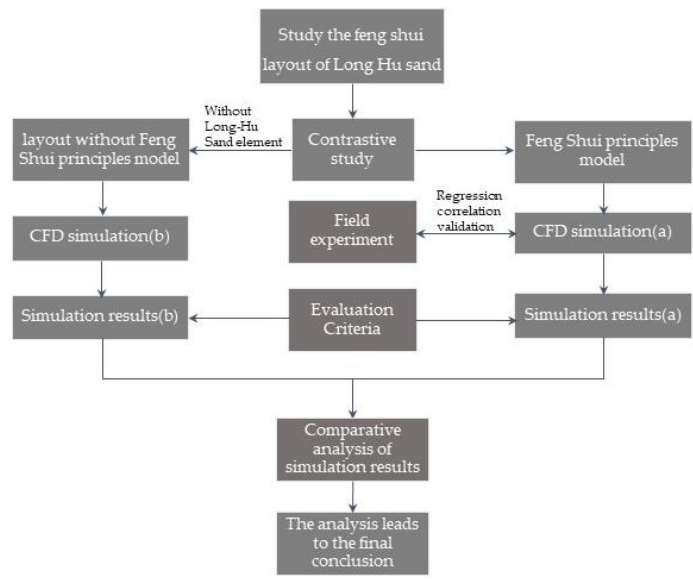
Figure 7. Research Figure 7. Research framework.